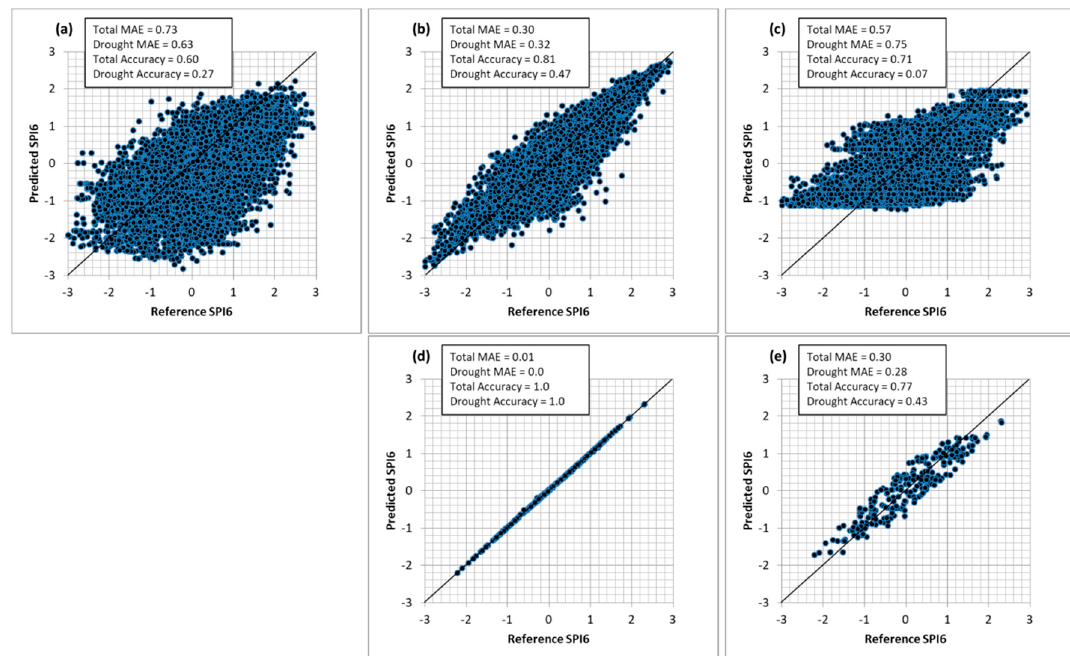
Figure 5. Scatter plots of reference SPI6 vs. 1-month lead SPI6 predictions for training based on ( a ) FCST_ONLY; ( b ) ERT_WRF; ( c ) Adaboost_WRF; ( d ) ERT_INSITU; and ( e ) Adaboost_INSITU.